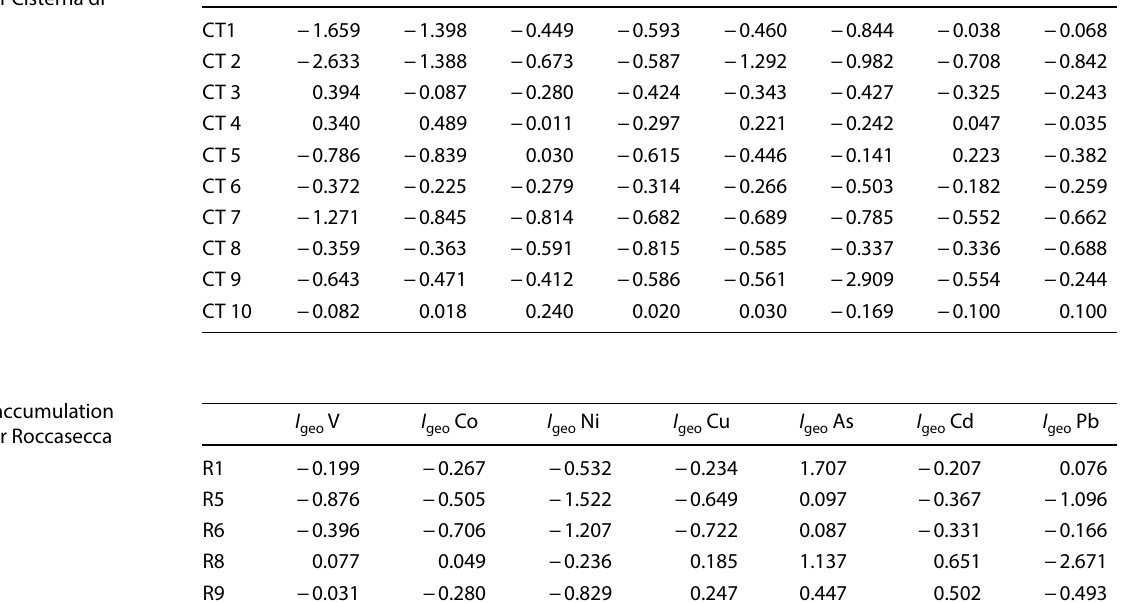
Table 4 Geoaccumulation index ( I geo ) for Cisterna di